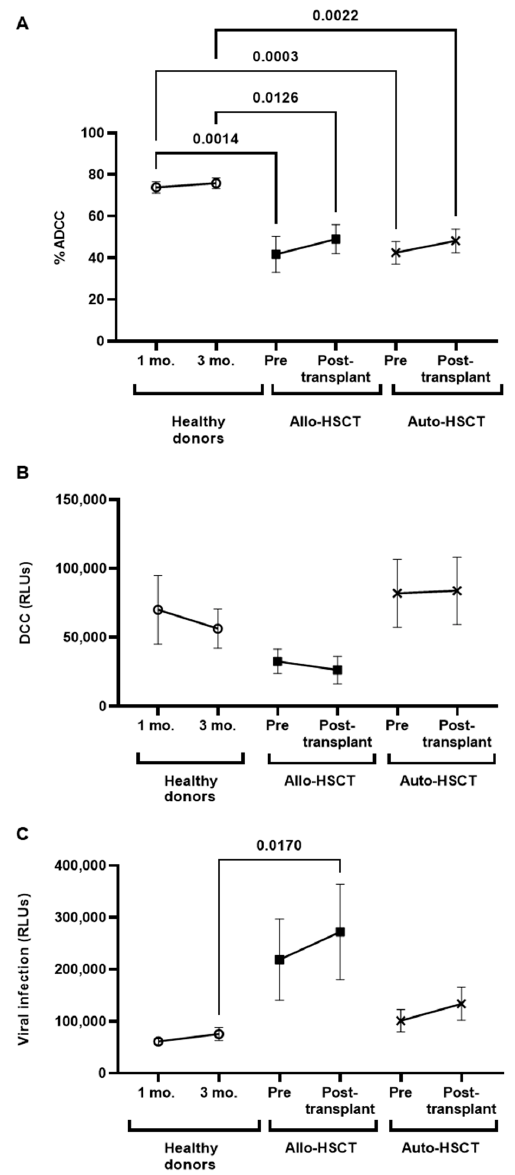
Figure 3. ADCC and DCC responses against SARS-CoV-2 of PBMCs from individuals with OHD